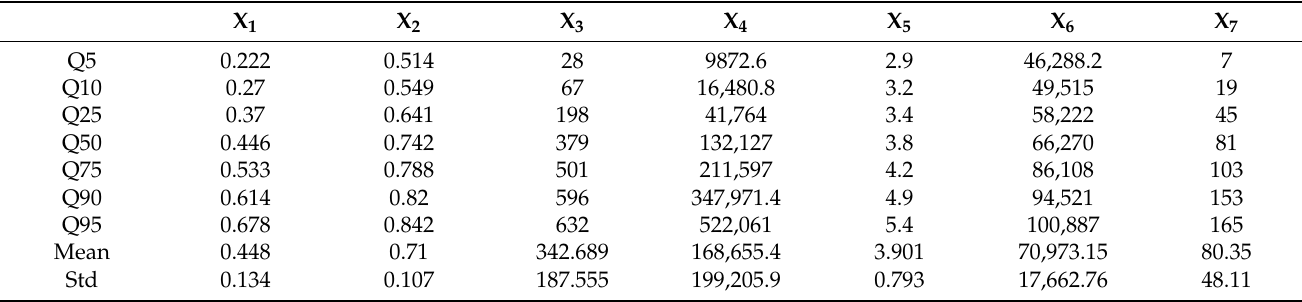
Table A1. Descriptive statistics for cluster 1.